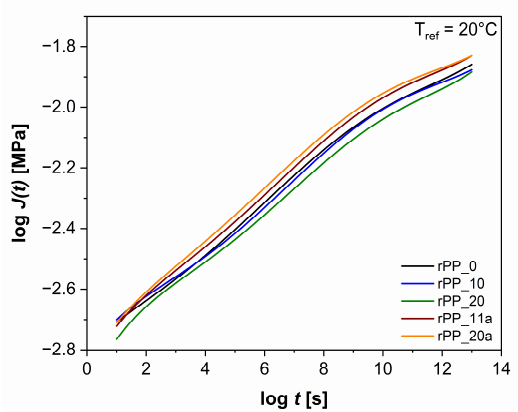
Figure 10. Creep master curve at the reference temperature ( T ref = 20 °C) for virgin PP, recycled PP without and with the additive.